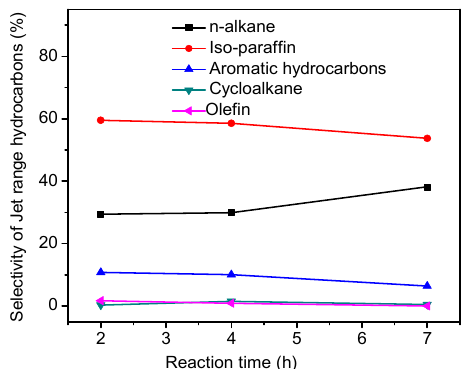
Figure 5. Selectivity for the formation of various jet-fuel-range hydrocarbons in the conversion of WCO over NiMo/SBUY-MCM-41. Reaction conditions: 380 °C, 3 MPa, 500 mL/mL.